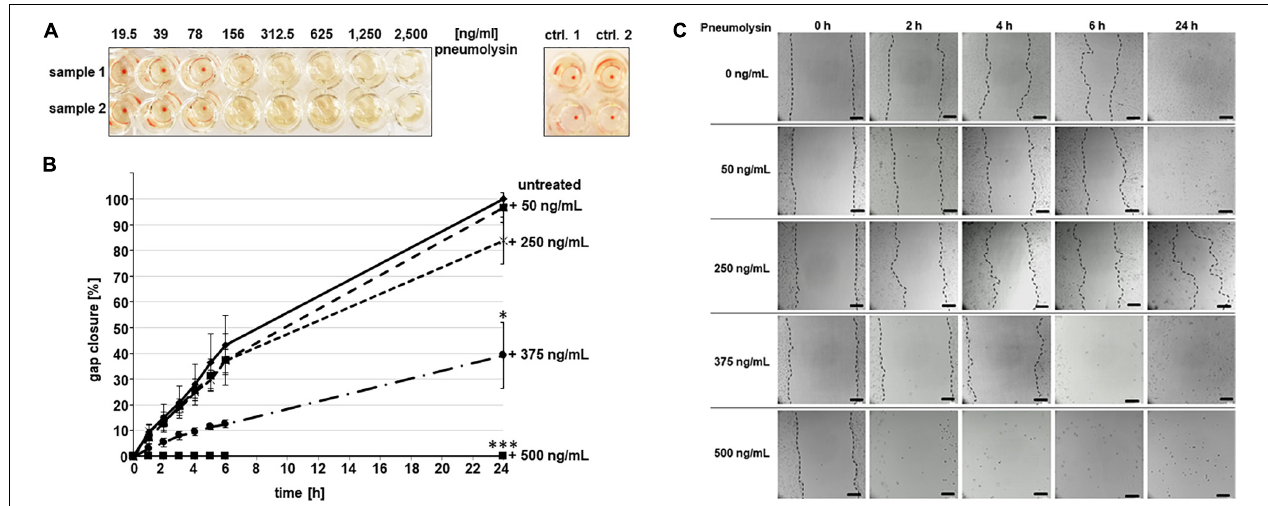
FIGURE 3 | Effect of purified pneumolysin protein on endothelial cell growth. (A) Toxic activity of pneumolysin was assessed by standardized hemolysis assay with pneumolysin protein in serial dilution between 19.5 and up to 2,500 ng/ml. The assay was repeated three times using technical duplicates. As controls, non-incubated erythrocytes (control 1) and buffer-incubated erythrocytes (control 2) were included. (B) CSMA was performed in the presence of pneumolysin protein in amounts of 50 ng/ml (dashed line with squares), 250 ng/ml (dashed line with crosses), 375 ng/ml (dashed line with dots), and 500 ng/ml (black line with filled squares; placed on the zero mark of the x -axis due to complete cell detachment). Gap closure was monitored and quantified after indicated time points for up to 24 h. Gap closure of untreated HUVEC was also determined as control (black line with filled rombi). All experiments were performed in three independent assays using three-chambered inlets, and data were expressed as mean value including standard deviation. * indicates p < 0.05, and *** indicates p < 0.01 according to two-tailed Welch’s T -test. (C) Representative images of live cell monitoring at time points 0, 2, 4, 6, and 24 h after incubation with indicated concentrations of pneumolysin protein. Scale bar represents 100 µ